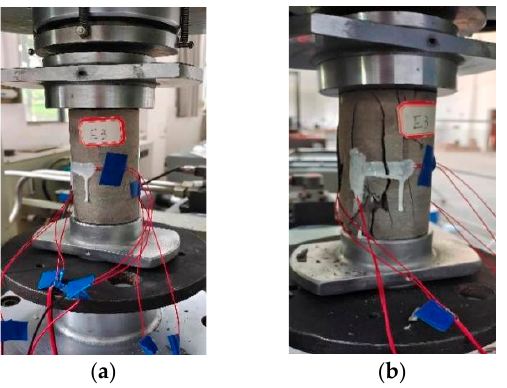
Figure 2. Experimental process. ( a ) Before the specimen experiment, ( b ) after the specimen experi-